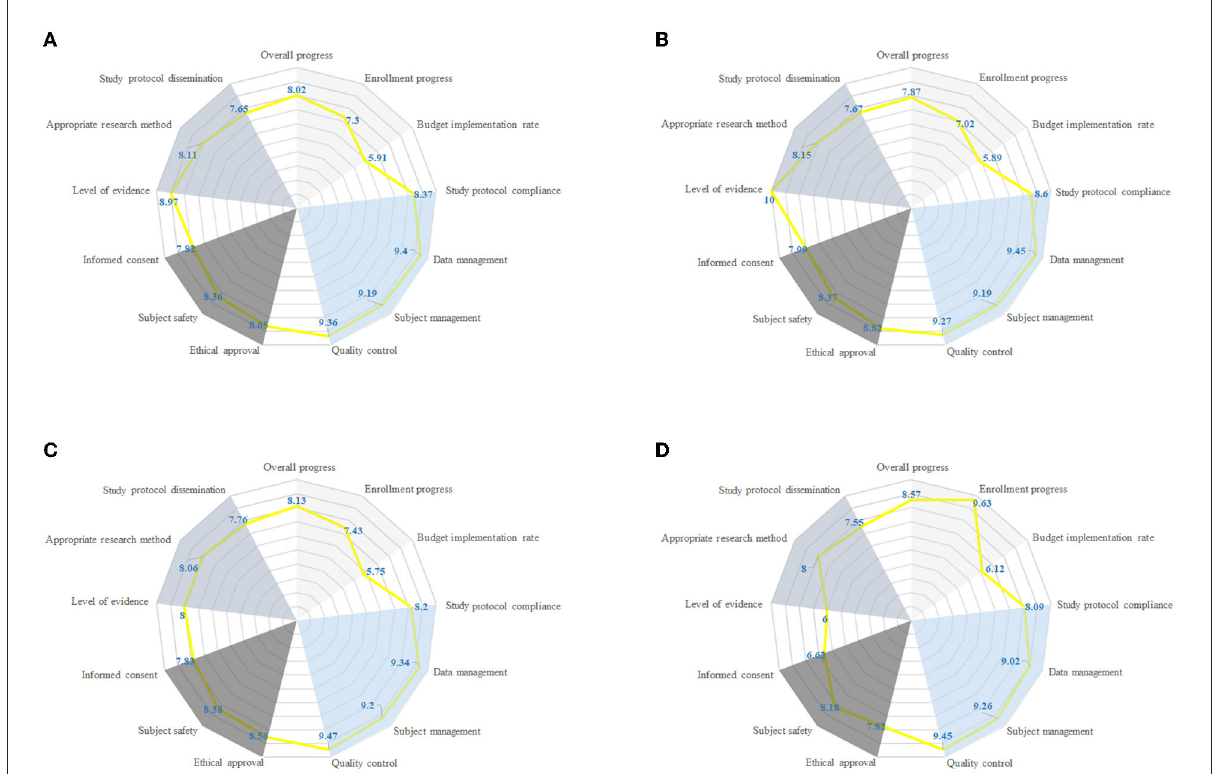
FIGURE4 Radar chart comparing different research type with respect to 13 quality characteristics (individual radial axes). Each axis shows fraction of IITs with given property, such as overall progress, enrollment progress, budget implementation rate. (A) Quality characteristics by all IITs. (B) Quality characteristics by RCT. (C) Quality characteristics by prospective cohort. (D) Quality characteristics by retrospective